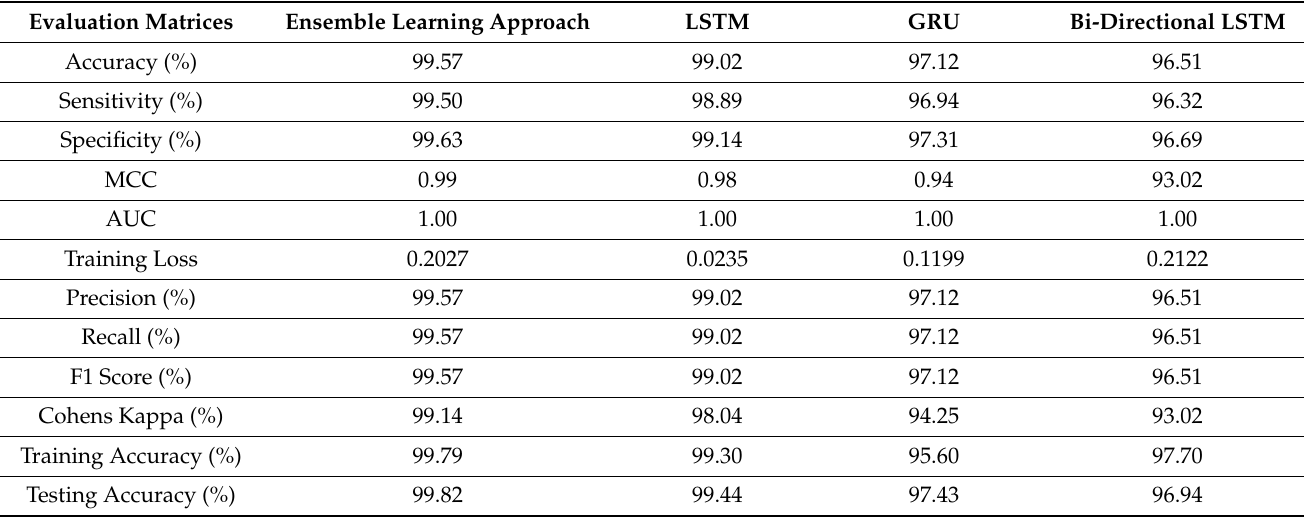
Table 4. Comparison of ensemble learning with individual deep learning techniques.